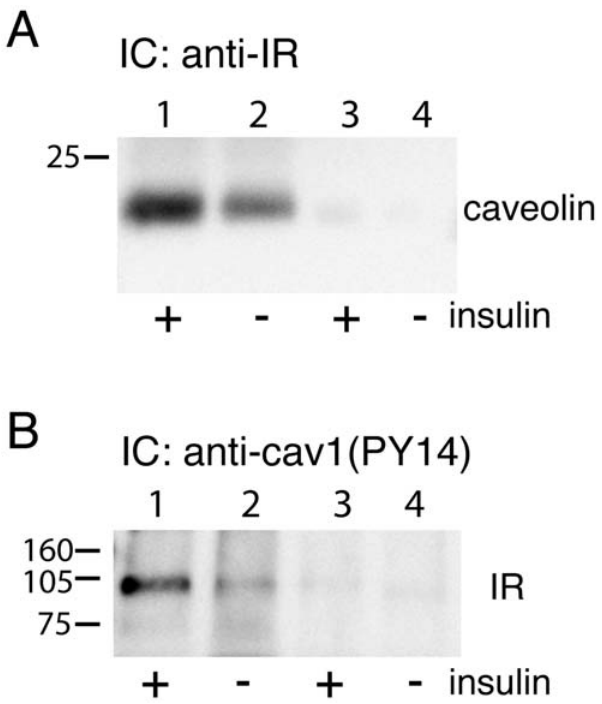
Figure 3. Immunocapture of vesicles in endosome fraction. Isolated adipocytes were incubated with or without 100 nM insulin, as indicated, for 10 min, when cells were homogenized and the endosomal fraction isolated. A. The endosomal fraction was incubated with antibodies against insulin receptor b -subunit (anti-IR) and immunocaptured (IC) (lanes 1 and 2). B. The endosomal fraction was incubated with antibodies against tyrosine(14)-phosphorylated caveo- lin-1 (anti-cav1(PY14)) and immunocaptured (lanes 1 and 2). Equal amount of protein was subjected to SDS-PAGE and immunoblotting with antibodies against caveolin-1 ( A ) and insulin receptor b -subunit (IR) ( B ). In the absence of primary antibody no antigen was immunodetected (lanes 3 and 4). Positions of reference proteins are indicated (kDa).